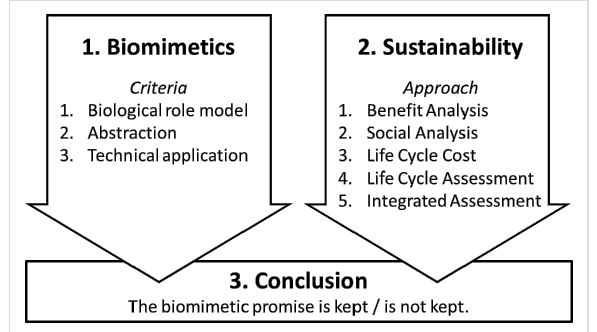
Figure 1: Three-stage validation procedure as to whether the biomi- metic promise of an innovative biomimetic product is kept or